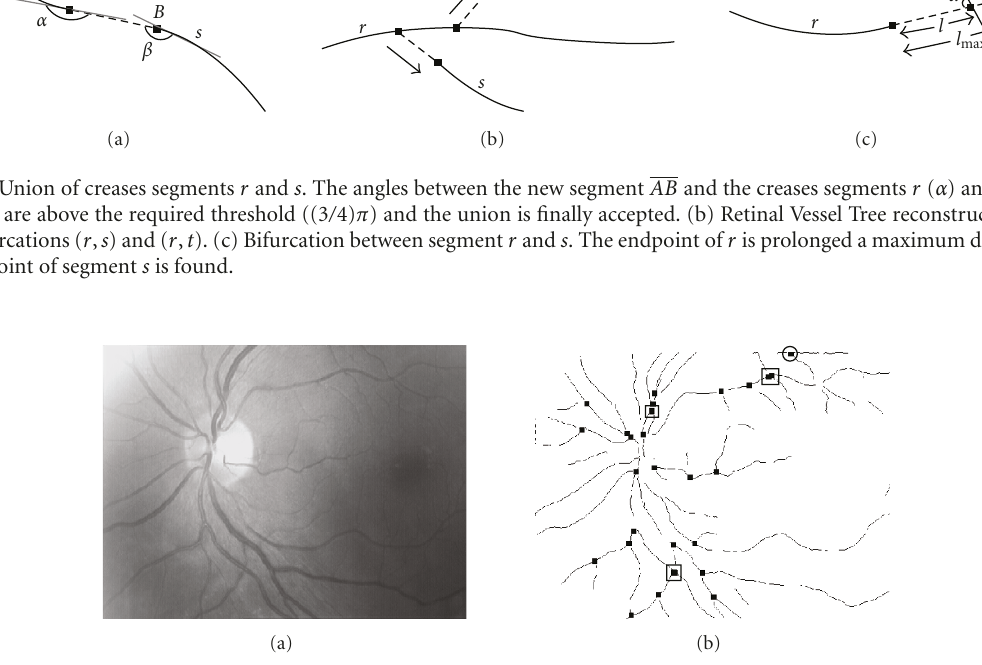
Figure 7: Example of feature points extracted from original image after the bifurcation/crossover stage. (a) Original Image. (b) Feature points marked over the segment image. Spurious points are signalled. Circles surrounding spurious points due to false segments extracted from the image borders and squares surrounding pairs of points corresponding to the same crossover (detected as two